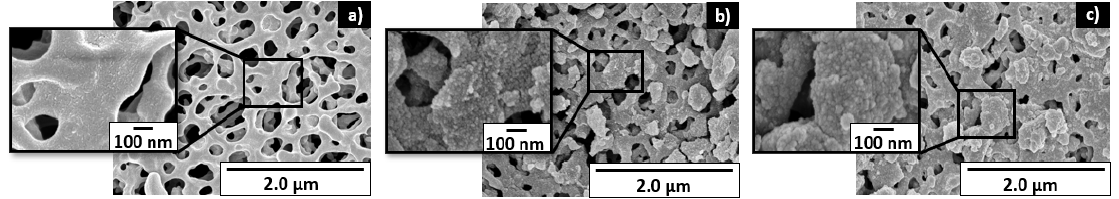
Figure 8. SEM images of the pristine porous polymeric substrates, together with the impregnated ones. ( a ) Pristine substrate (without nanopowders), ( b ) impregnated with pure TiO 2 and with ( c ) 5 mol% of Fe-TiO 2 nanopowders with the addition of PEG. EDS analyses were also carried out on these substrates, as shown in Figure